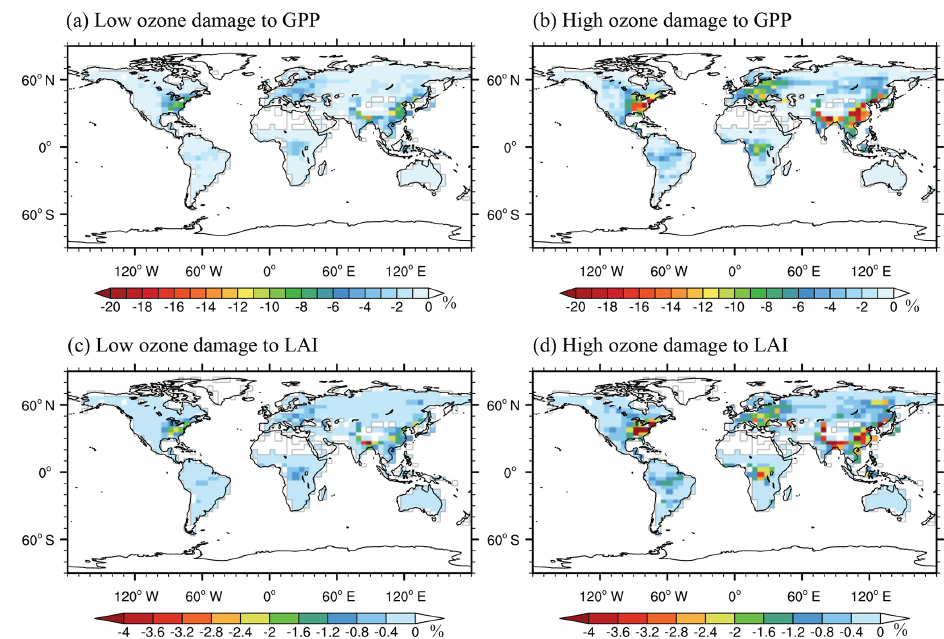
Figure 10. Percentage changes in (a, b) GPP and (c, d) LAI caused by the damaging effects of O 3 with (a, c) low (Online_ALL_LS simulation) and (b, d) high sensitivities (Online_ALL_HS simulation). Both changes of GPP and LAI are averaged for